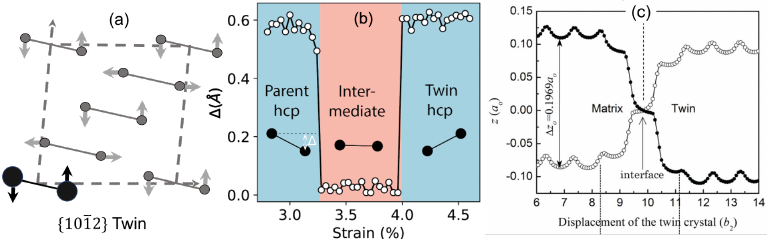
Figure 4. ( a ) The motif pair [31] of atoms traced in our simulation is highlighted, which shuffles perpendicular to the { 10¯12 } twin boundary. ( b ) The evolution of ∆ during the hcp-tetragonal-hcp martensitic phase transformation, where ∆ is the distance of the motif pair perpendicular to the { 10¯12 } twin plane. The movement of the motif pair in our simulations agrees with ( c ) the atomic movement in the twinning dislocation-based mechanism [39]. ∆ in ( b ) corresponds to ∆ z in ( c